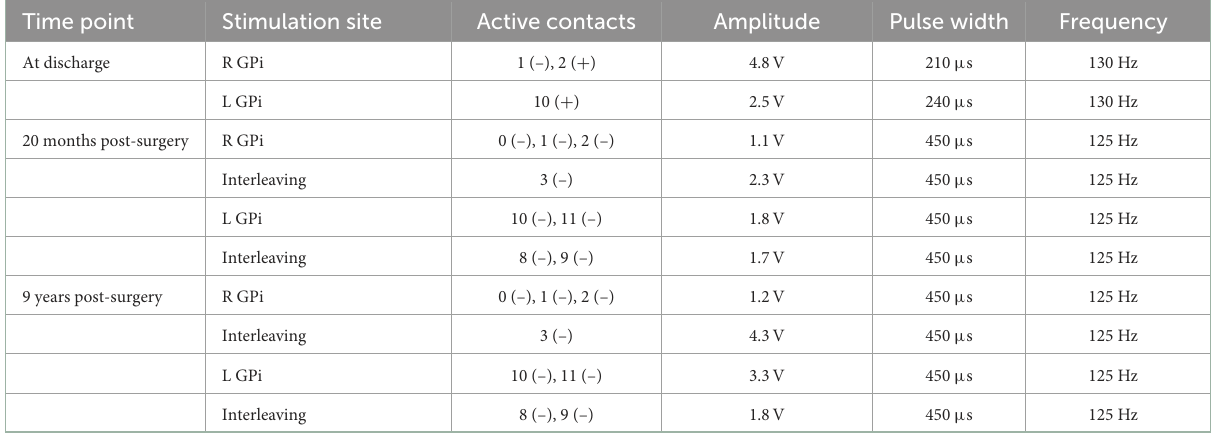
TABLE 1 Stimulation settings at discharge, 20 months post-surgery, and 9 years post-surgery. Time